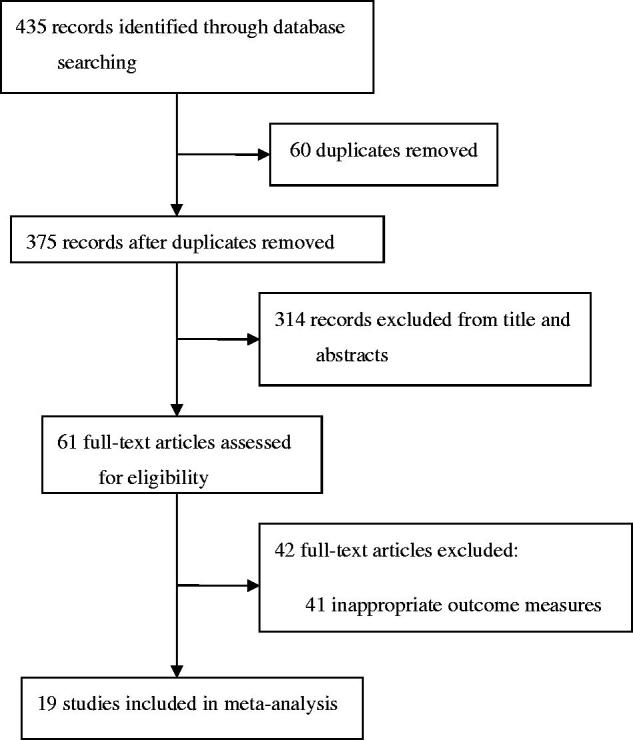
Study selection.